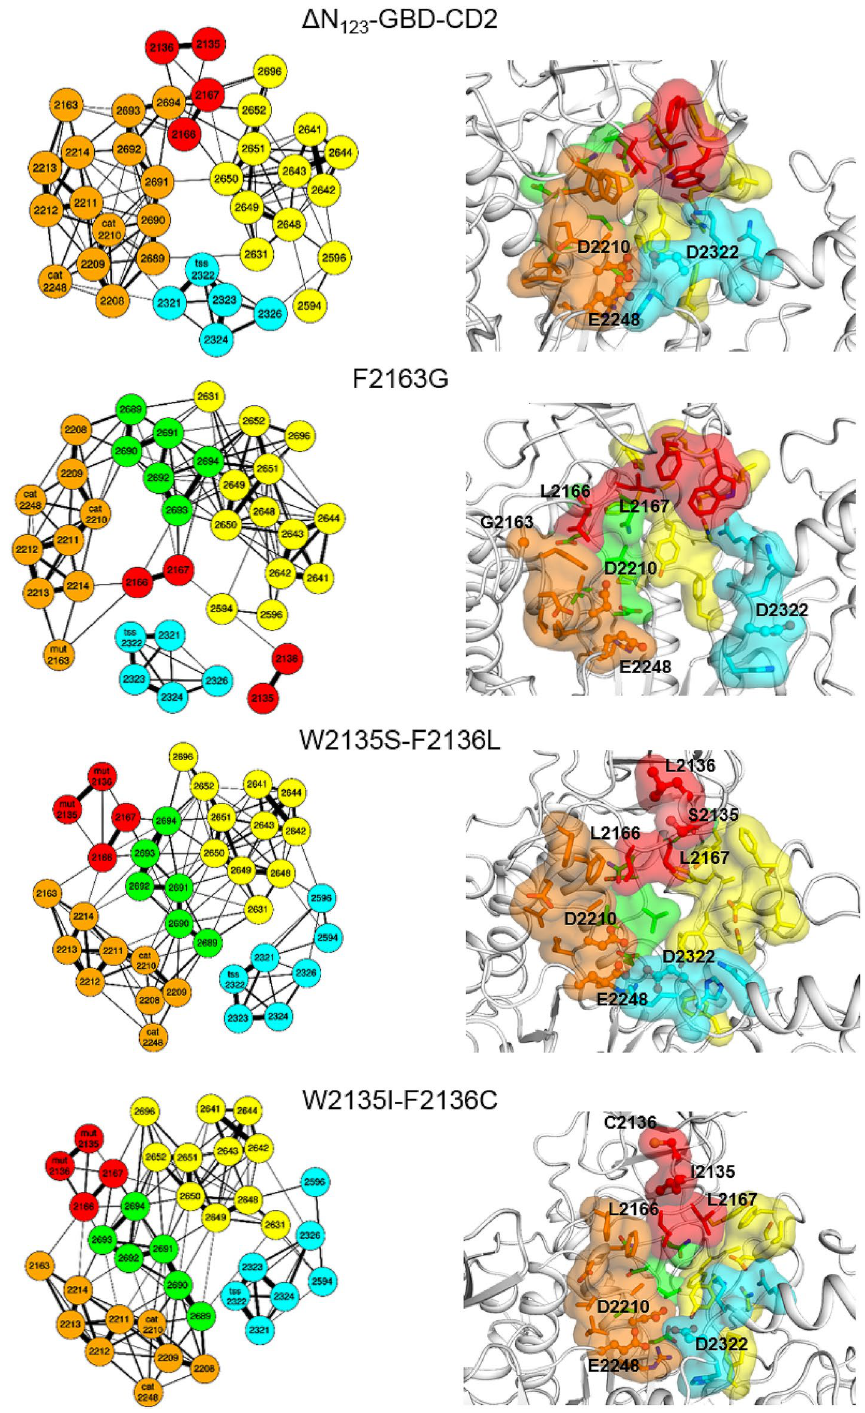
Figure 6. Comparison of network communities (left) and structural representation (right) derived from MD analysis. Left: Active site residues network presented by spring layout using Fruchterman-Reingold algorithm from distance matrixes from 1 µs MD simulations of the parental ΔN 123 -GBD-CD2, the F2163G mutant, and the double mutants W2135S-F2136L and W2135I-F2136C. Amino acid communities highlighted with orange, red, green, yellow and cyan colors were found by spin-glass algorithm. The catalytic, the transition state stabilizer, and the mutated residues are labelled respectively by “cat”, “tss” and “mut” for each corresponding graph. Right: View of active site residue clusters from the spin-glass algorithm for the parental ΔN 123 -GBD-CD2 and the mutants F2136G, W2135S-F2136L, and W2135I-F2136C. The 5 communities are presented: I (orange), II (green), III (red), IV (yellow) and V (cyan). Three dimensional structures are taken from the low energy regions of the free energy landscapes of each system (Fig. 5). Graphs in figures were drawn using the R software 39